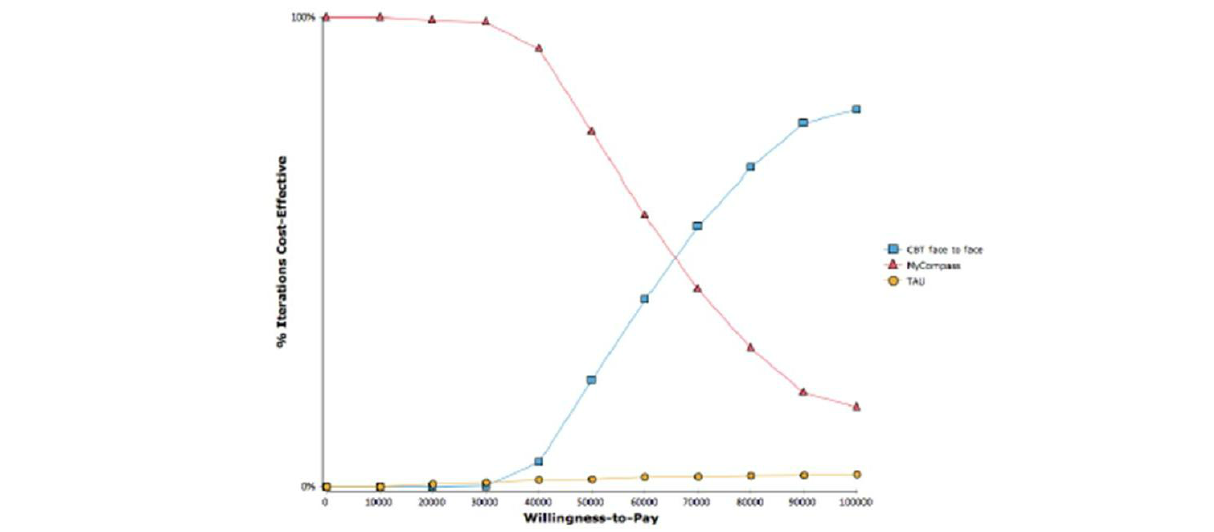
Figure 3. Cost-effectiveness acceptability curve: myCompass versus CBT and TAU.